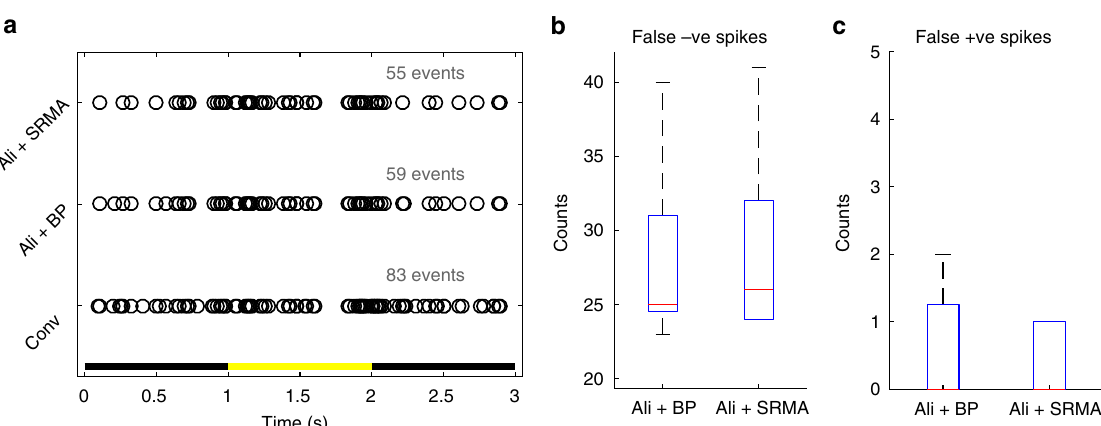
Fig. 1 Impacts of aliasing on spike detection performance. a The retina was stimulated with a 1 s light fl ash. Comparing to non-aliased recording (Conv), aliased recordings (Ali), regardless of processing strategy (bandpass; BP; 300 – 3k Hz or SRMA) registered less events. Summary of false positive ( b ) and false negative ( c ) events across fi ve repetitions of the 1 s light fl ash